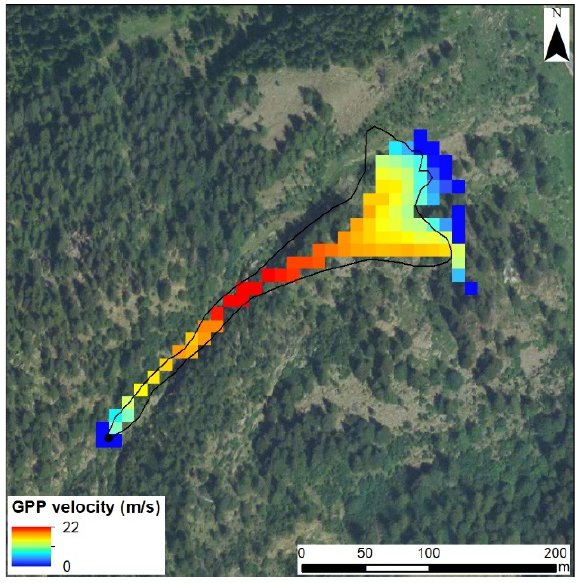
Figure 7. Velocity values of the shallow landslide, shown in Figure 5, obtained by the GPP model. The continuous black line corresponds to the landslide boundary, and the black point to the release reference point according to the IFFI inventory.